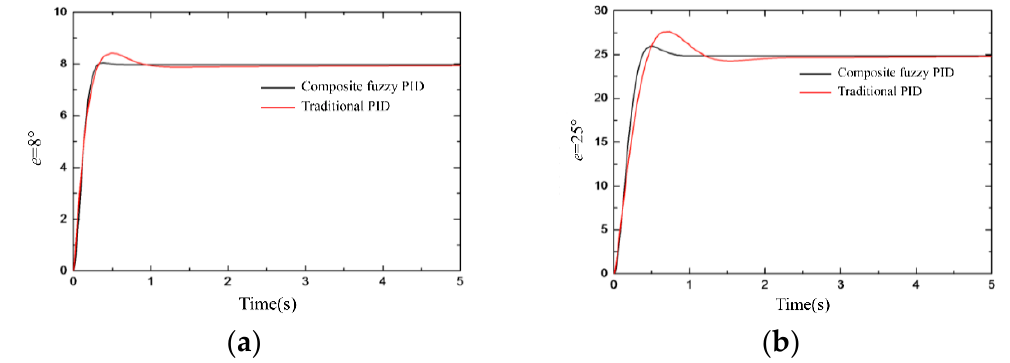
Figure 7. Step signal response curve: ( a ) Simulation curve at 8°; ( b ) simulation curve at 25°.